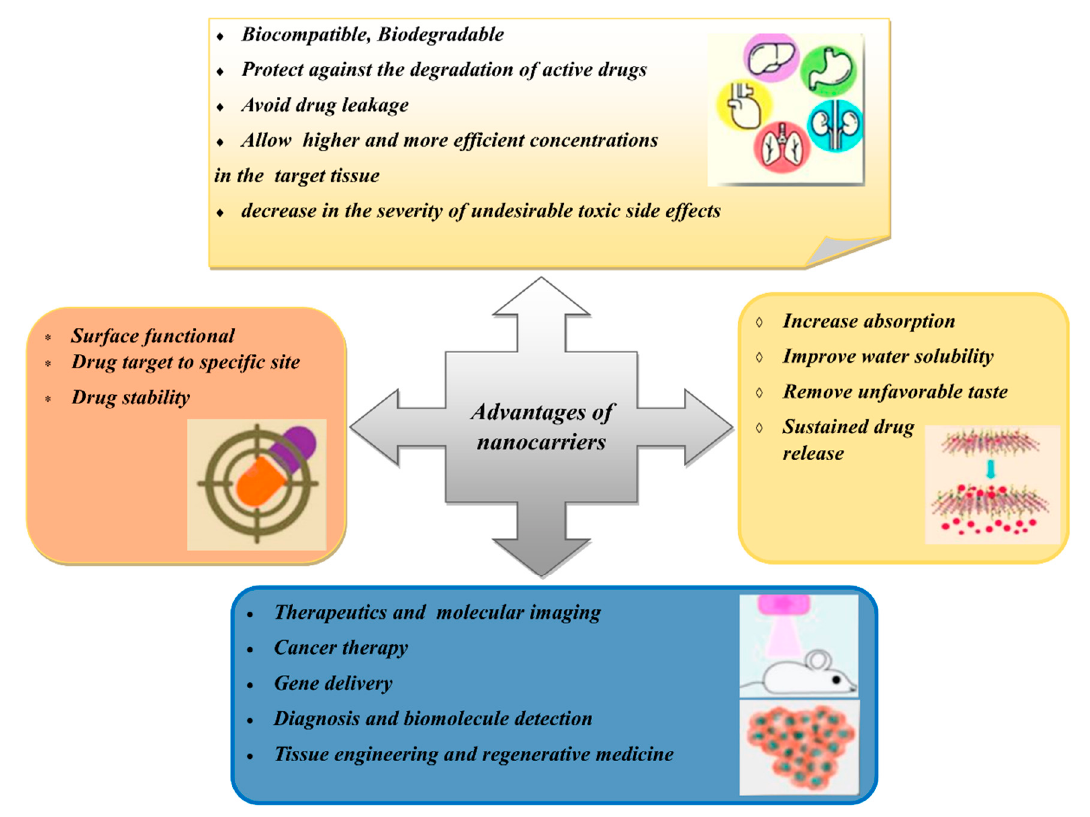
Figure 2. Advantages of using nanocarriers for plant extracts and bioactive constituents.